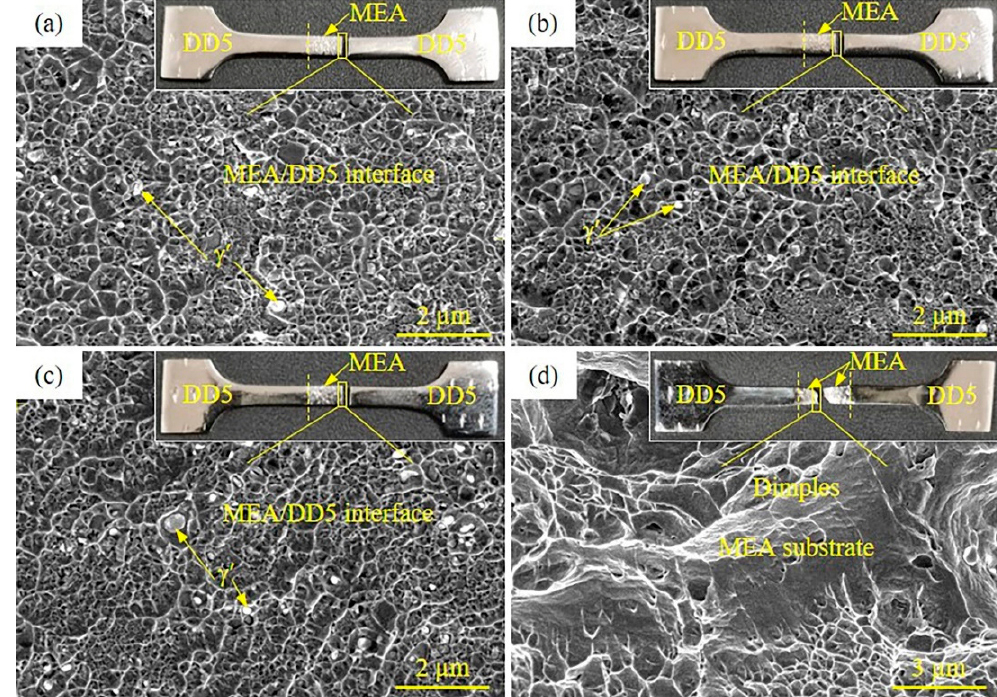
Figure 8. Macro fracture and magnified surface morphologies of the joints diffusion-bonded at ( a ) 1020 °C, ( b ) 1050 °C, ( c ) 1080 °C, and ( d ) 1110 °C.